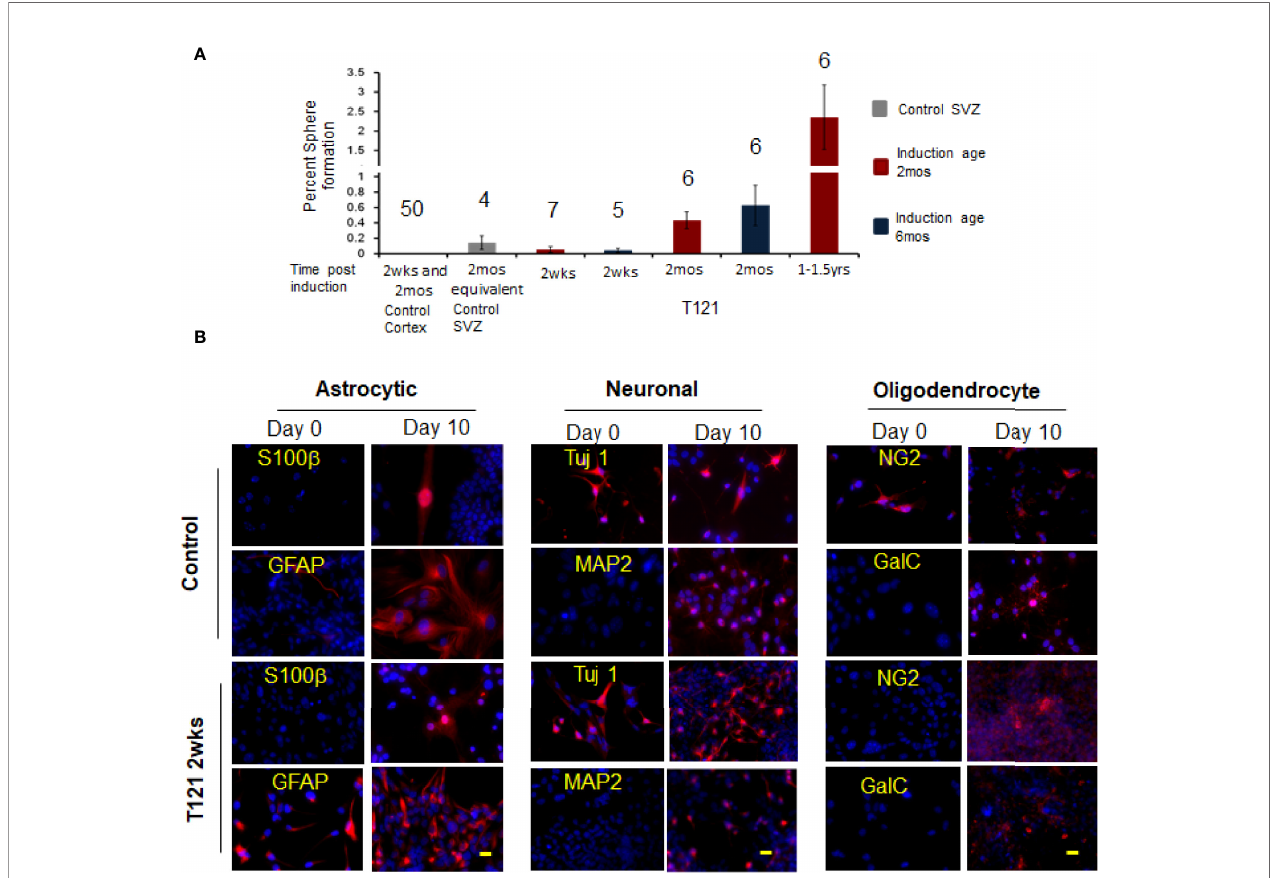
FIGURE 4 | In vivo progenitor-like cells have the ability to form spheres and differentiate into multiple neuronal lineages. (A) The histogram shows percent sphere formation for cortical cells isolated from either control mice or 4OHT induced mice at different time points. The mice were either induced at the age of 2 mos. red bars or induced at the age of 6 mos. blue bars. The gray bar is sphere formation from SVZ cells which are control cells to evaluate the assay conditions. The time post induction is indicated below each bar. There were 4,000 cells used for each assay and the number above the bar indicates the number of mice evaluated for each time point. (B) Images showing presence of differentiation markers for the three neuronal lineages. Within each neuronal lineage, top panel shows differentiation of control neurosphere cells (adult stem cells isolated from 3mos old wildtype mouse). Bottom row is differentiation of neurosphere cells from T 121 2wks post induced cells. Left column shows neurosphere cells at day 0 and Right column differentiated cells. Cells were cultured in absence of growth factors and presence of serum for 10 days to differentiate into the three lineages. Astrocytes markers S100 b (Red) and GFAP (Red) were used to indicate differentiation. For neuronal lineage Tuj1 (Red) and MAP2 (Red) and for oligodendrocytic lineage NG2 (Red) and GalC (Red). Nuclei counterstained with DAPI (blue). Scale bar indicates 20